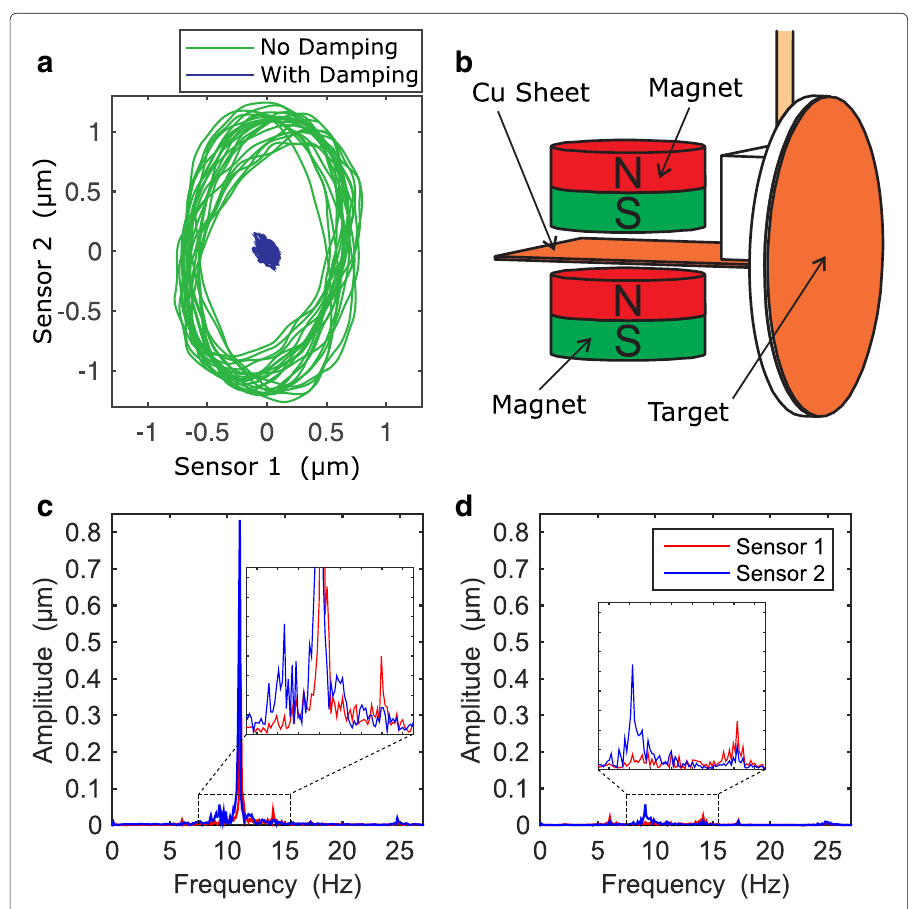
Fig. 3 Mechanical oscillations of the cantilever and its damping. a Lissajous curves made up from the displacements measured by the two sensors during two seconds. b Sketch of the eddy current damping parts. c Frequency spectra of the displacements measured by the two sensors without damping and d with damping. The insets show the marked regions, respectively, with ten times enlarged